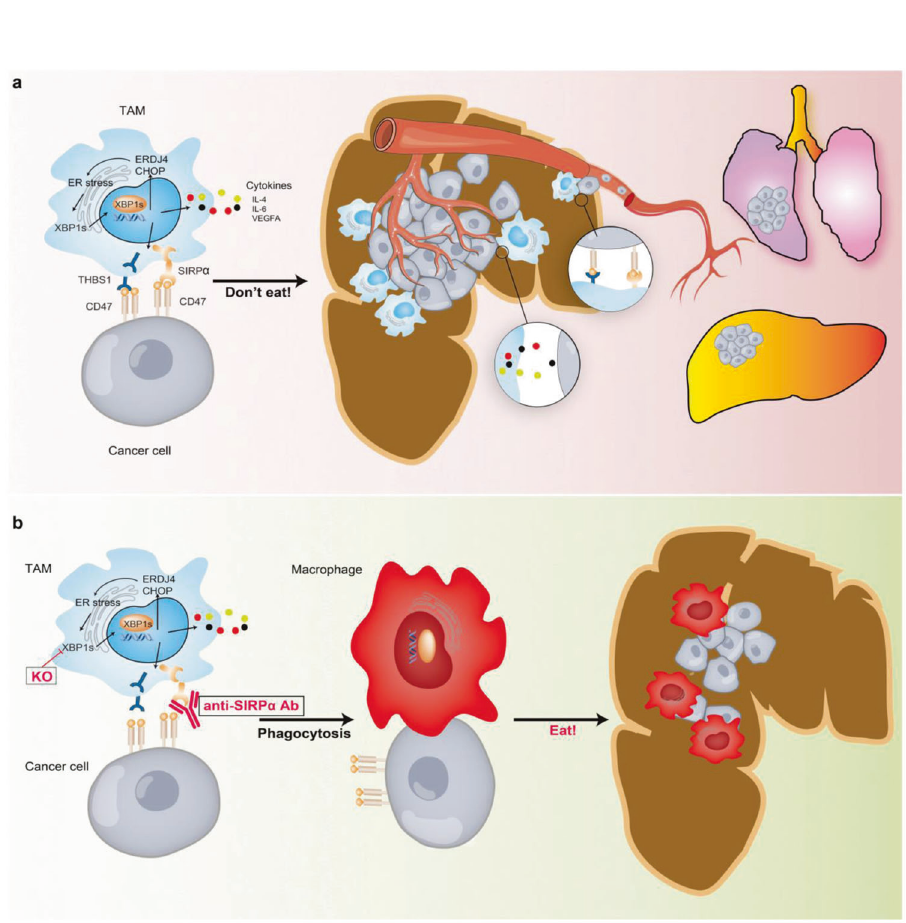
Fig. 7 Scheme depicting the contribution of XBP1 in TAMs to colon cancer progression. a In the tumor microenvironment, activation of UPR/ ER-XBP1 signaling in TAMs induced the production of cytokines, which inhibited macrophage phagocytosis of tumor cells via the disruption of self-recognition. Therefore, TAMs promote the metastasis of colorectal cancer. b Disabling UPR/ER-XBP1 signaling or treatment with anti- SIRP α antibodies may enhance anti-cancer capacity in a harsh tumor committees of the Cancer Hospital, Chinese Academy of Medical Sciences. The clinical backgrounds for these patients are shown in Supplementary Tables S1 – S3. Peripheral blood was collected from patients and centrifuged with Ficoll density gradient, following which the middle layer cells were gathered for fl uorescence- activated cell sorting (FACS) analysis. Mice were housed at our Institutional Animal Care unit. All animal experiment protocols were approved by the ethical committee of the Chinese Academy of Medical Sciences, Cancer Hospital.